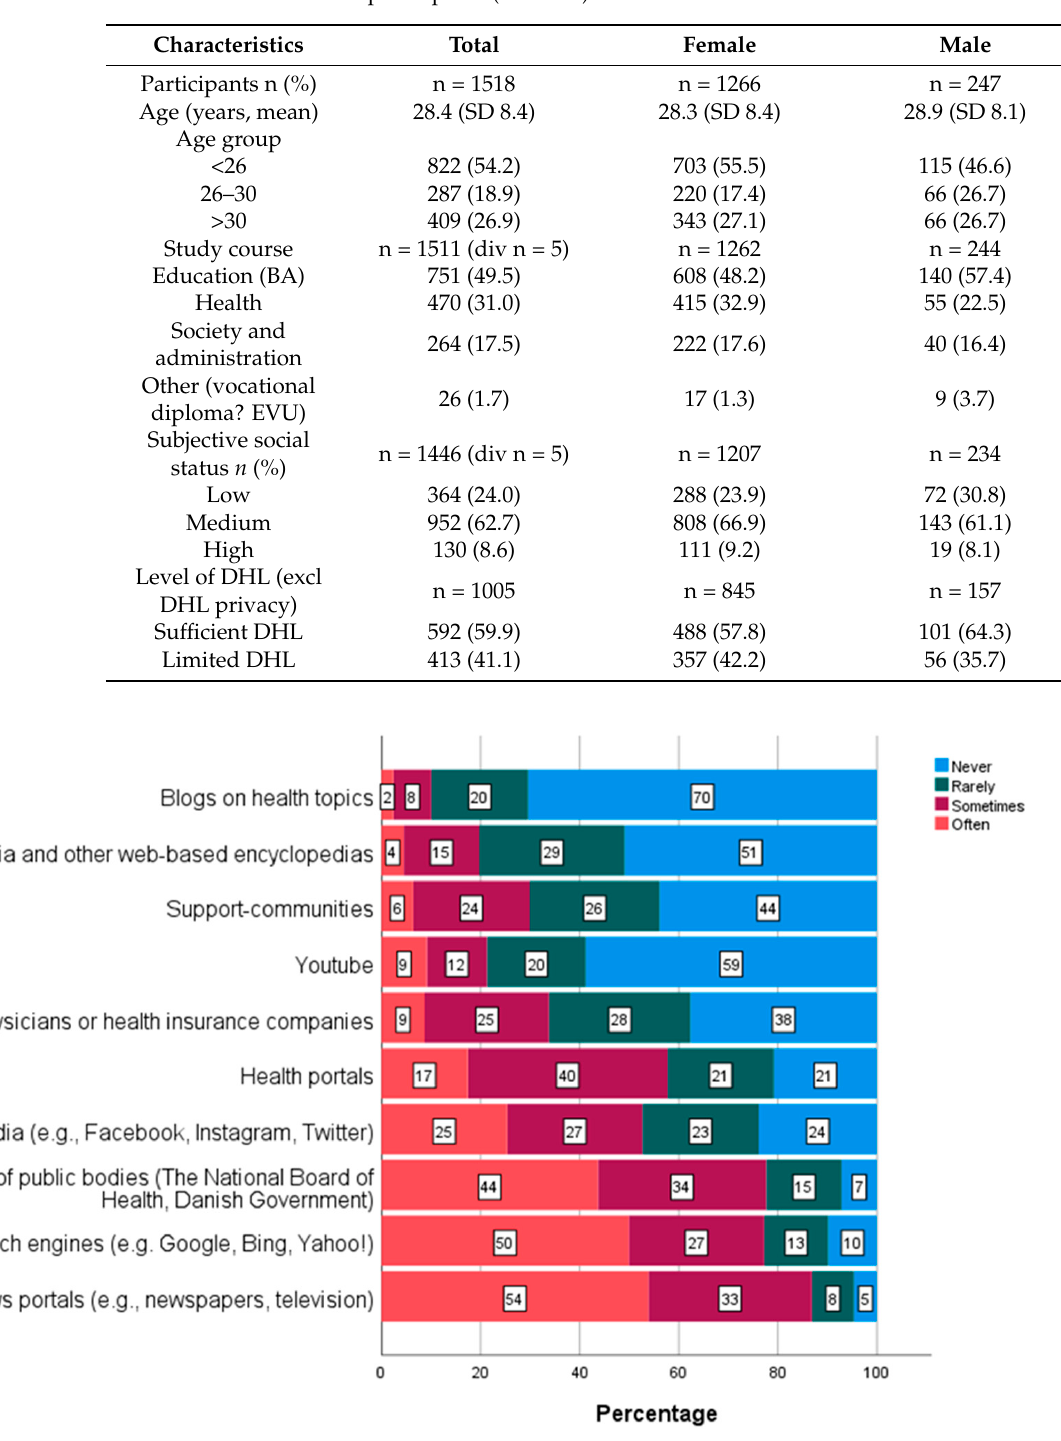
Figure 2. Frequency of use of internet sources for web-based health information seeking (n = 1468 to n = 1513), Pct.